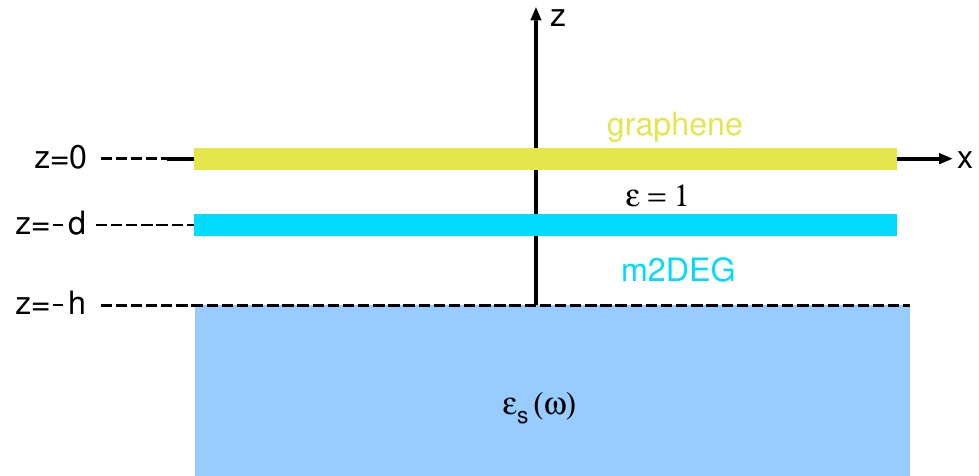
Figure 3. Schematic representation of the reduced model. The alkali atom layer is approximated by ‘massive’ 2D electron gas (parabolic σ band), and the graphene layer is described by the ‘massless’ Dirac fermion (MDF) approximation (conical π